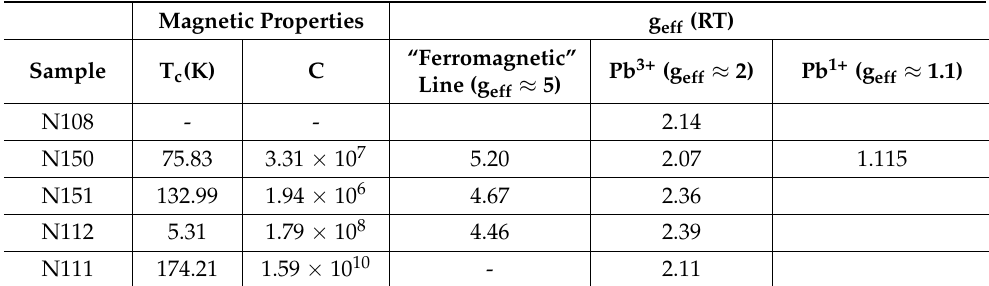
Table 1. Summary of the Curie temperature with constant and g eff parameters from EPR measure- ments at room